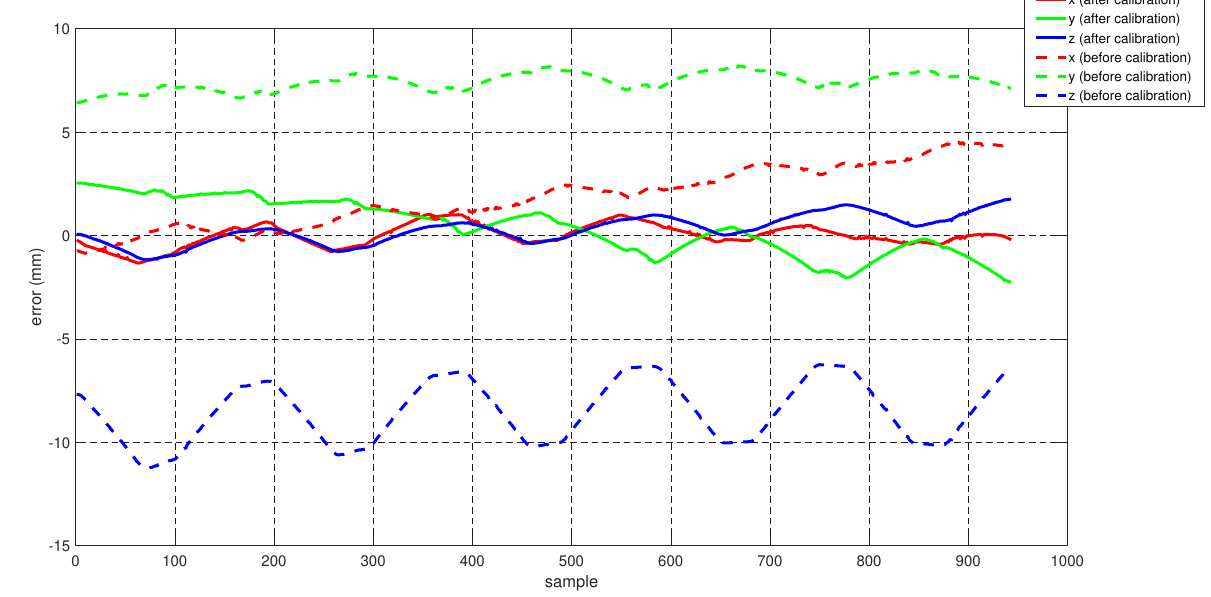
Figure 17. Test set position error along individual